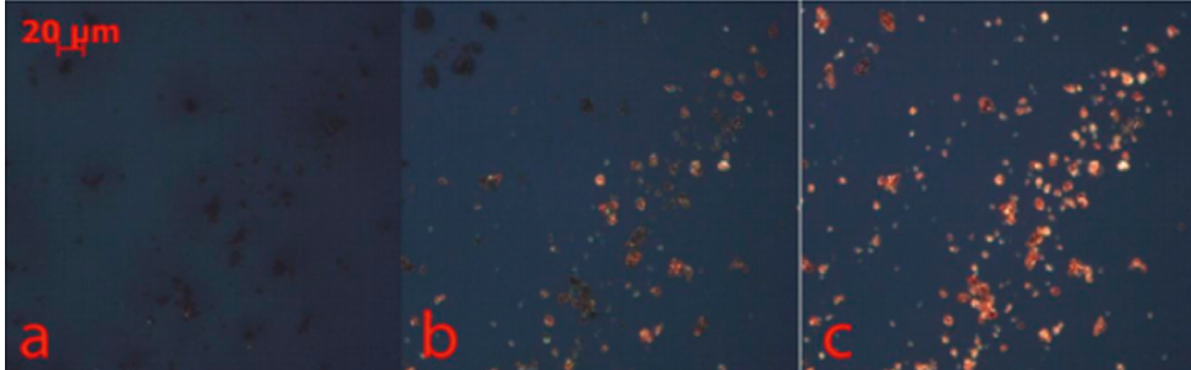
Figure 15: Topographic images showing the interaction between n-heptane and asphaltenes. (a) Asphaltene with n-heptane, (b) asphaltene during n-heptane evaporation, and (c) asphaltene after evaporation of n-heptane. The figure is obtained from Nikooyeh [47] (under the creative commons attribution license/public domain).